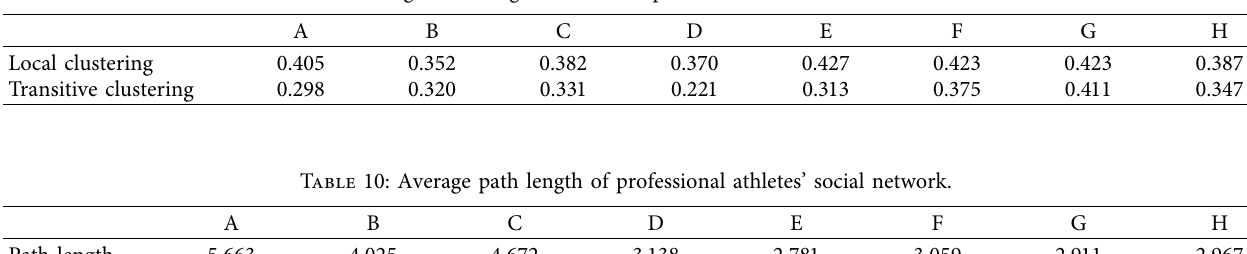
Table 9: Average clustering coefficient of professional athletes’ social network.